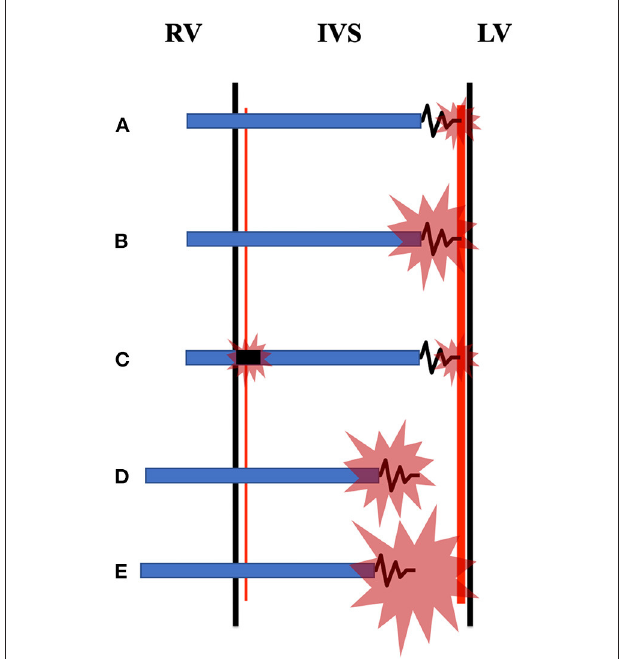
FIGURE 1 | Diagrammatic sketch of left bundle branch pacing (LBBP) and left ventricular septal pacing (LVSP) with different pacing modes. (A) Selective LBBP (SLBBP) captures only the left bundle branch (LBB) trunk or its proximal bundle, resulting in physiologically left ventricle (LV) excitation but delayed right ventricle (RV) excitation. Non-selective LBBP (NSLBBP) is divided into two types: (B) , which excites the LBB and surrounding myocardium, and (E) , which excites the LBB and the left ventricular septal myocardium. (C) In bipolar pacing configuration, the cathode tip of LBBP captures the LBB and the anode ring captures the right bundle branch at the same time, probably due to the anodal capture. (D) LVSP captures only the left ventricular septal myocardium. RV, right ventricle; IVS, interventricular septum; LV, left